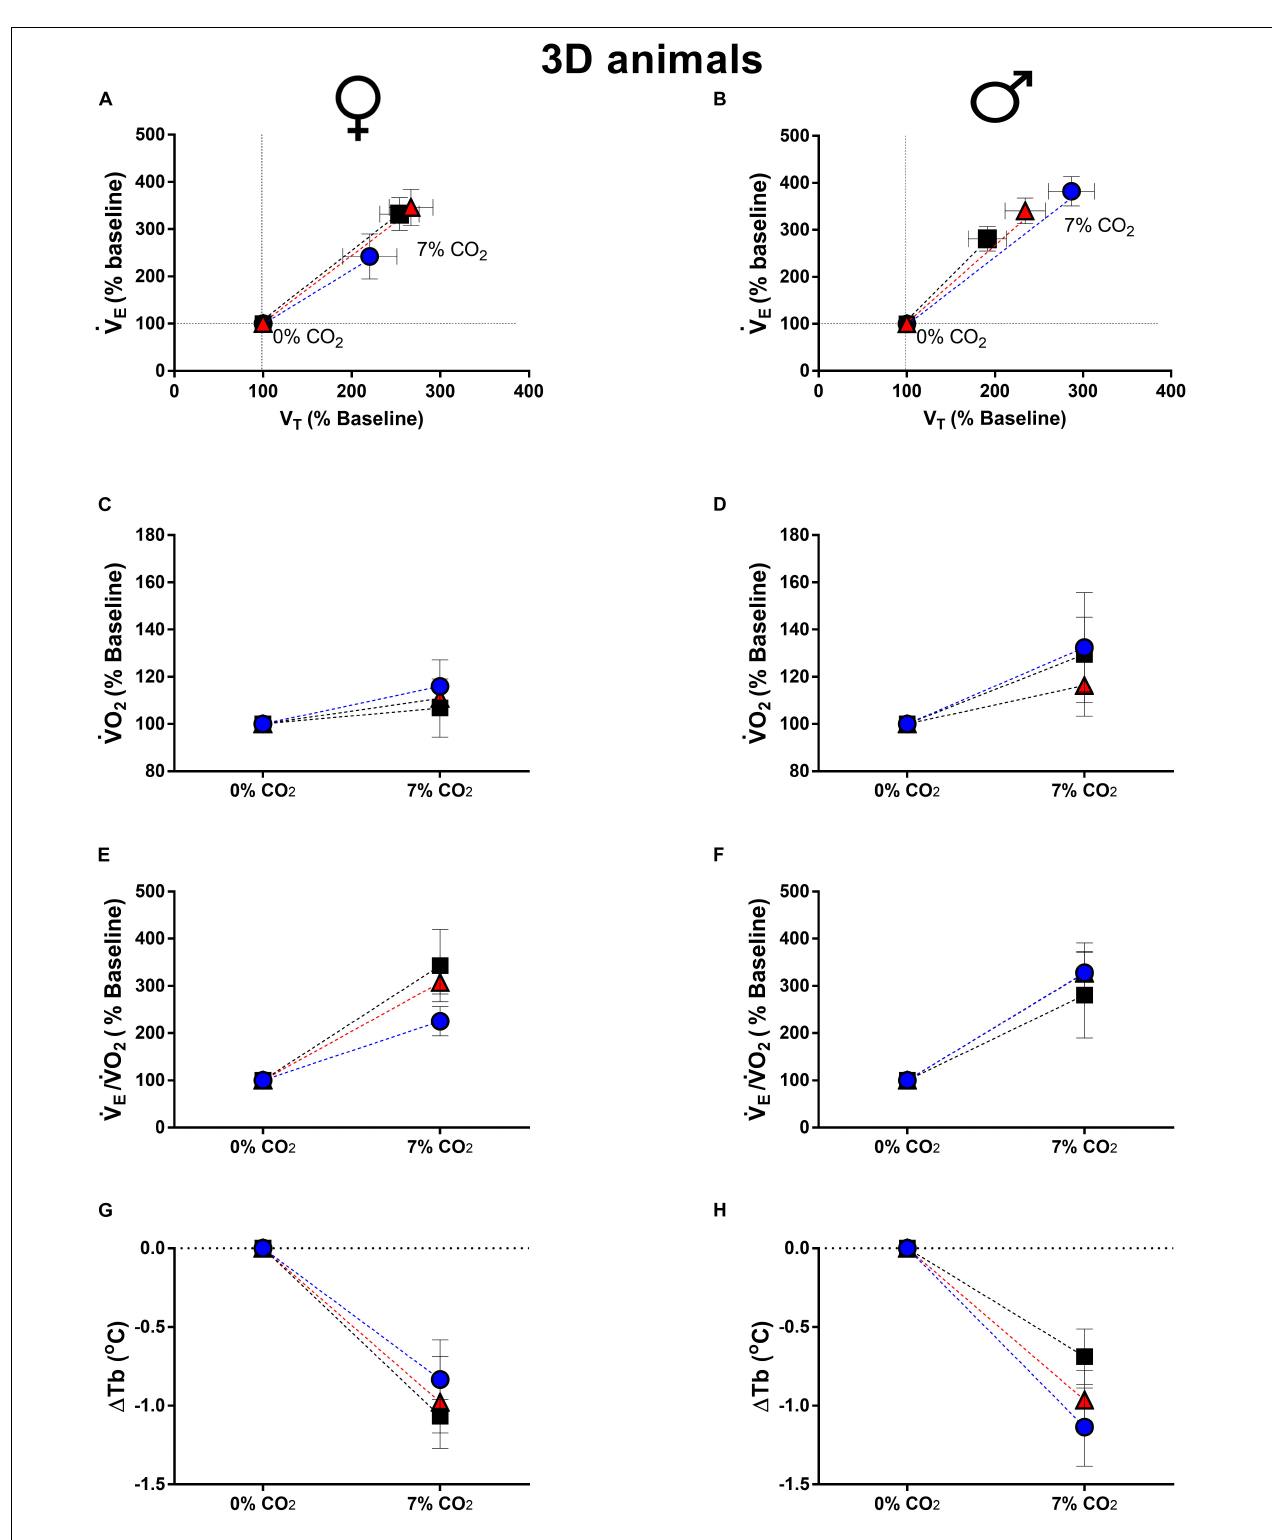
FIGURE 1 | Breathing pattern (A,B) , oxygen consumption ( ˙ V O 2 ) (C,D) , air convection requirement ( ˙ V E / ˙ V O 2 ) (E,F) and body temperature (Tb) (G,H) , during normocapnia and hypercapnia of 3-days-old female and male chickens submitted to the experimental treatments during incubation, i.e., control temperature (CT, 37.5 ◦ C), low temperature (LT, 36 ◦ C, 6 h/day, from 0 to 5th day) and high temperature (HT, 39 ◦ C, 6 h/day, from 0 to 5th day). Values are expressed as mean ± SEM. Different letters represent statistical differences among the treatments. Level of significance: P ≤ 0.05.